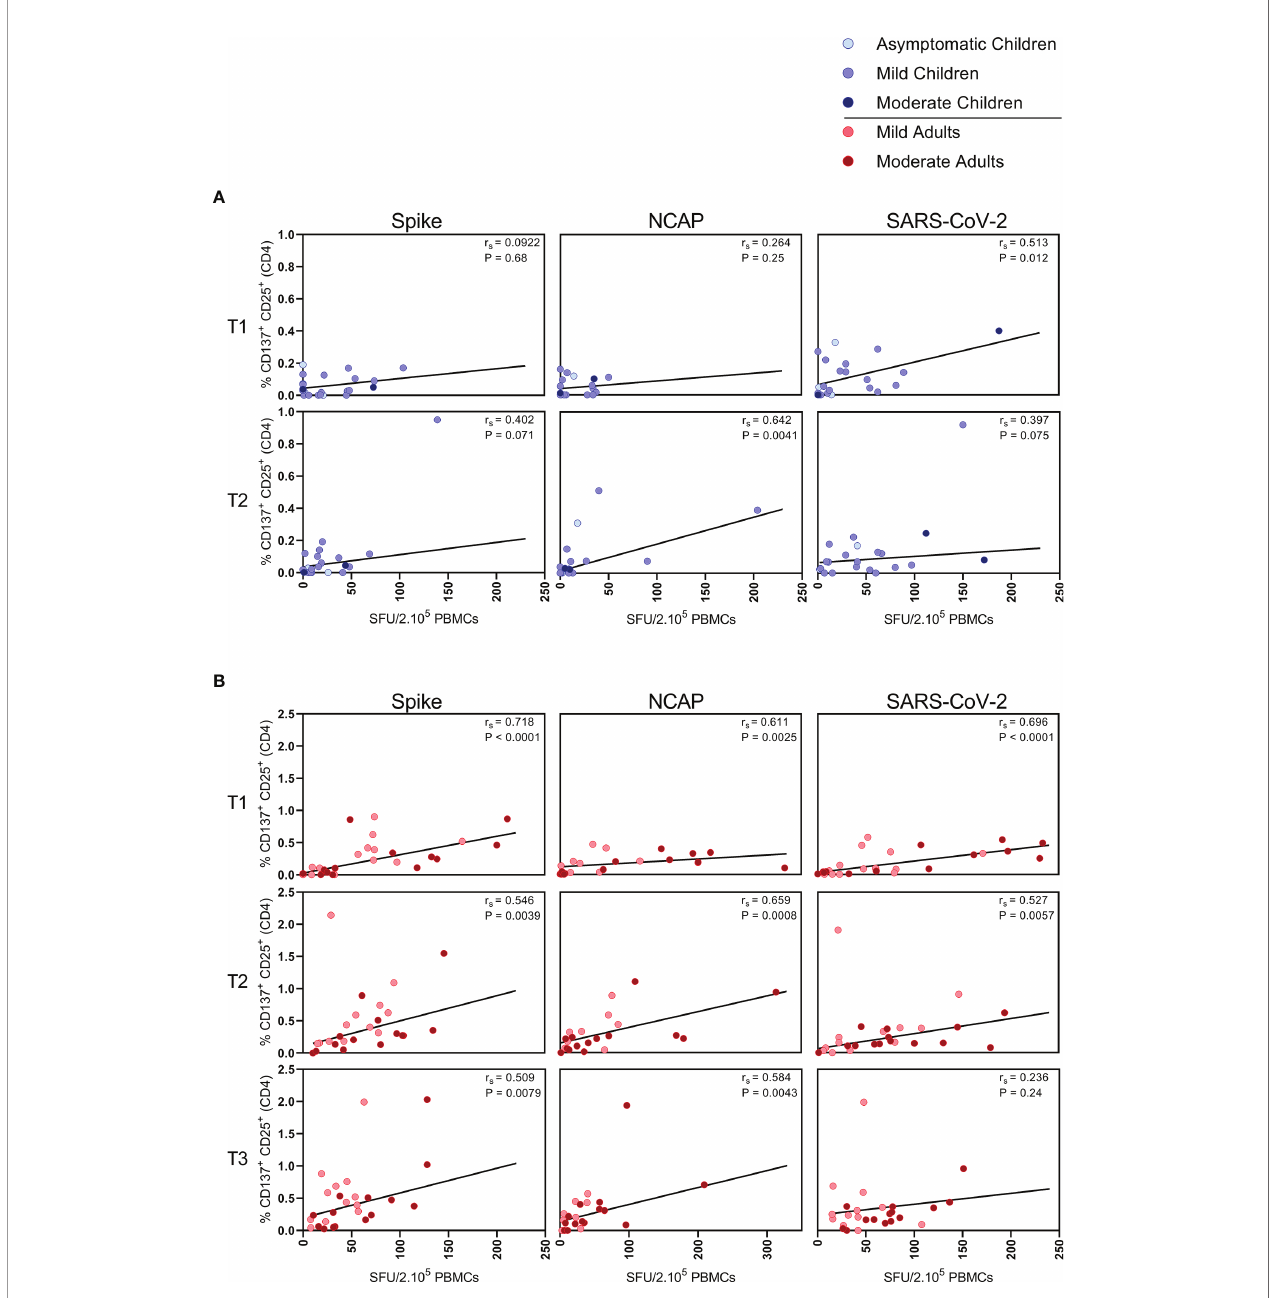
FIGURE 3 | Correlation between IFN- ɣ + T cell frequency and activated CD4+ T cells. Spearman correlation between frequency of IFN- ɣ + responder cells and percentages of CD25+/CD137+ activated CD4+ T cells of (A) children and (B) adults responding to a set of overlapping peptides of SARS-CoV-2 spike protein (left panel), or a set of overlapping peptides of SARS-CoV-2 nucleocapsid protein (middle panel) or inactivated SARS-CoV-2 (right panel) at different time points after infection. Each dot represents one subject. Correlation coef fi cients (rs) were determined with Spearman ’ s rank correlation. P values < 0.05 were considered signi fi cant. T1, fi rst timepoint of sampling for adults median 12.5 days and children median 8 days post-symptom onset; T2, 10-14 days after T1; T3, 4-6 weeks after